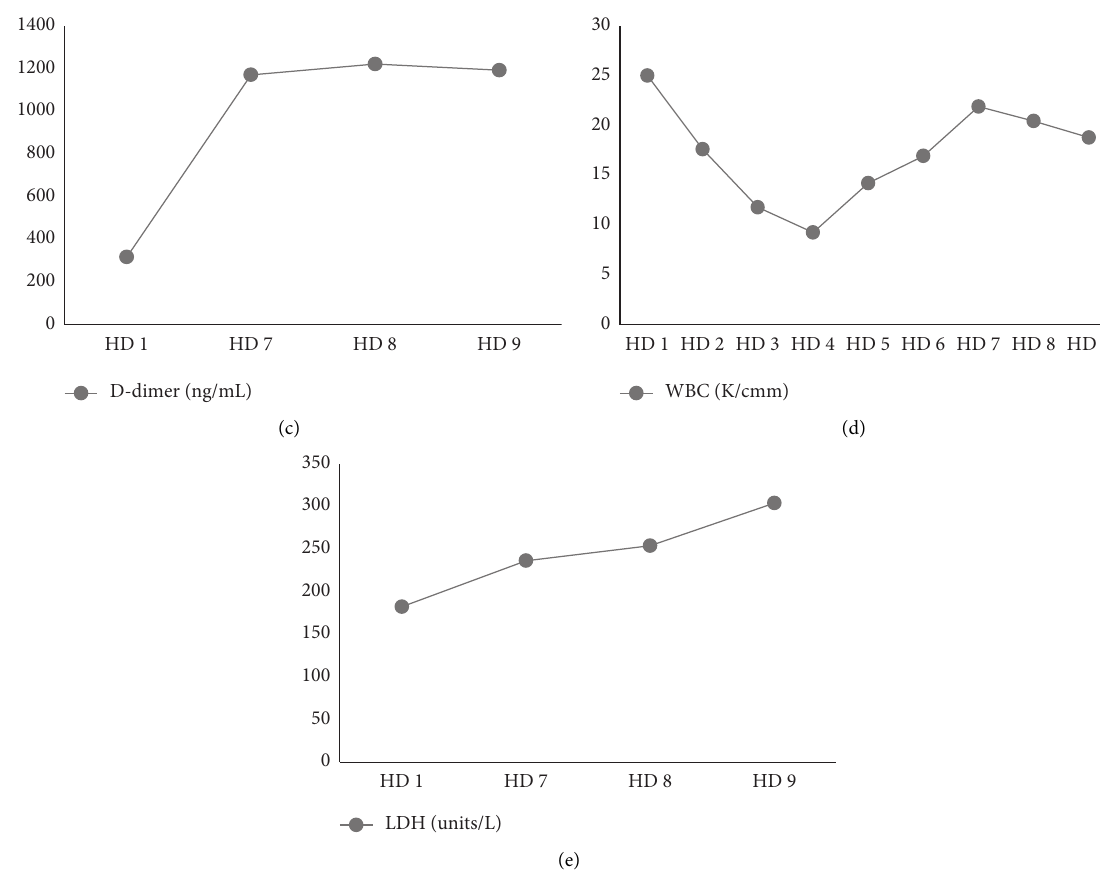
Figure 2: A graphical representation of (a) serum C-reactive protein, (b) serum ferritin, (c) quantitative D-dimer, (d) white blood cell count, and (e) serum lactate dehydrogenase. HD, hospital day. ∗ Unstable to quantify CRP value greater than 160